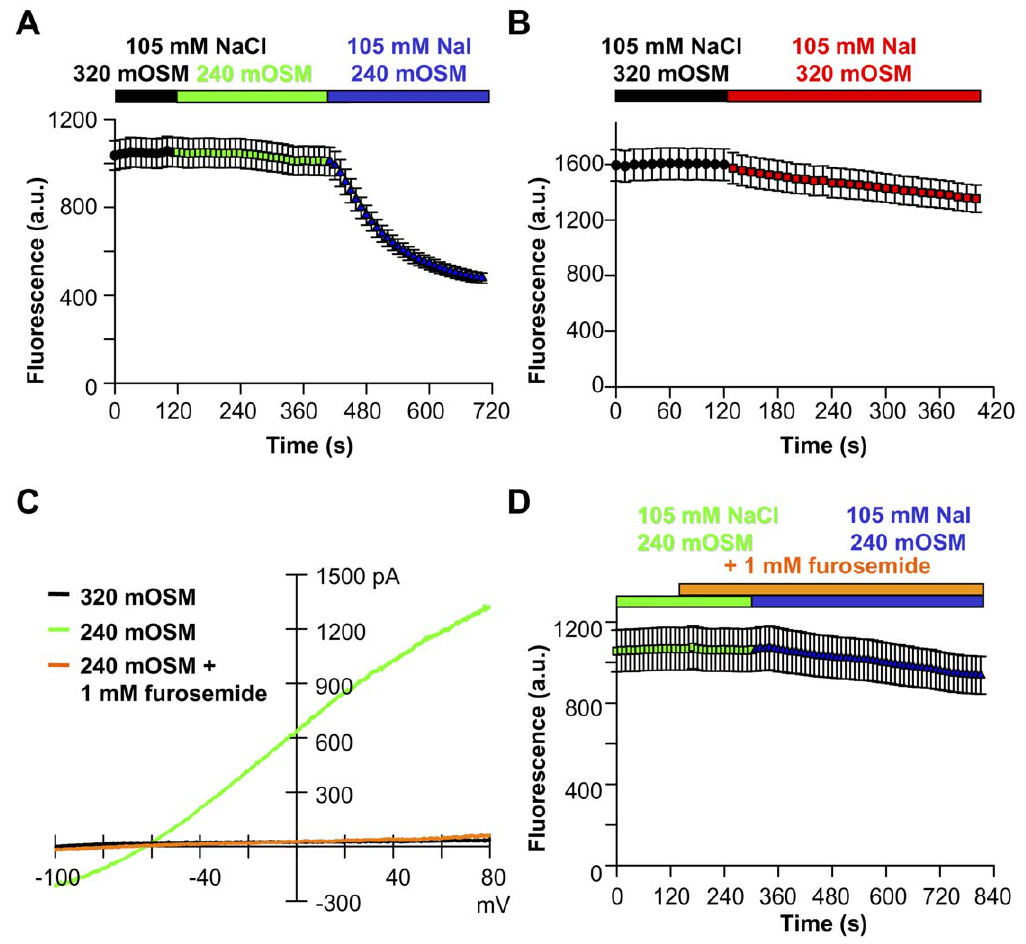
Figure 3. H148Q-YFP stably expressed in S2R + cells reports the entry of I 2 through activated Cl swell channels. ( A ) Cellular swelling in 240 mOSM Cl 2 did not alter fluorescence intensity as Cl swell channels activate (Student’s t-test, p=0.65; n=76). Replacement of Cl 2 with I 2 evoked a 51% 6 1.3 decrease in fluorescence (Student’s t-test, p , 0.001; n=76). Imaging assay; fluorescence is in arbitrary units (a.u.). ( B ) Cl swell channels must be open for I – induced fluorescence suppression to occur. 320 mOSM NaI suppresses fluorescence by 16% 6 0.7 (Student’s t-test, p=0.1; n=54). ( C ) Furosemide, an NKCC2 blocker, completely inhibits the S2R + cell Cl swell channels at 1 mM (n=3). ( D ) 1 mM Furosemide block of Cl swell prevents significant I – induced suppression of H148Q-YFP fluorescence (Student’s t-test, p=0.54; n=16).